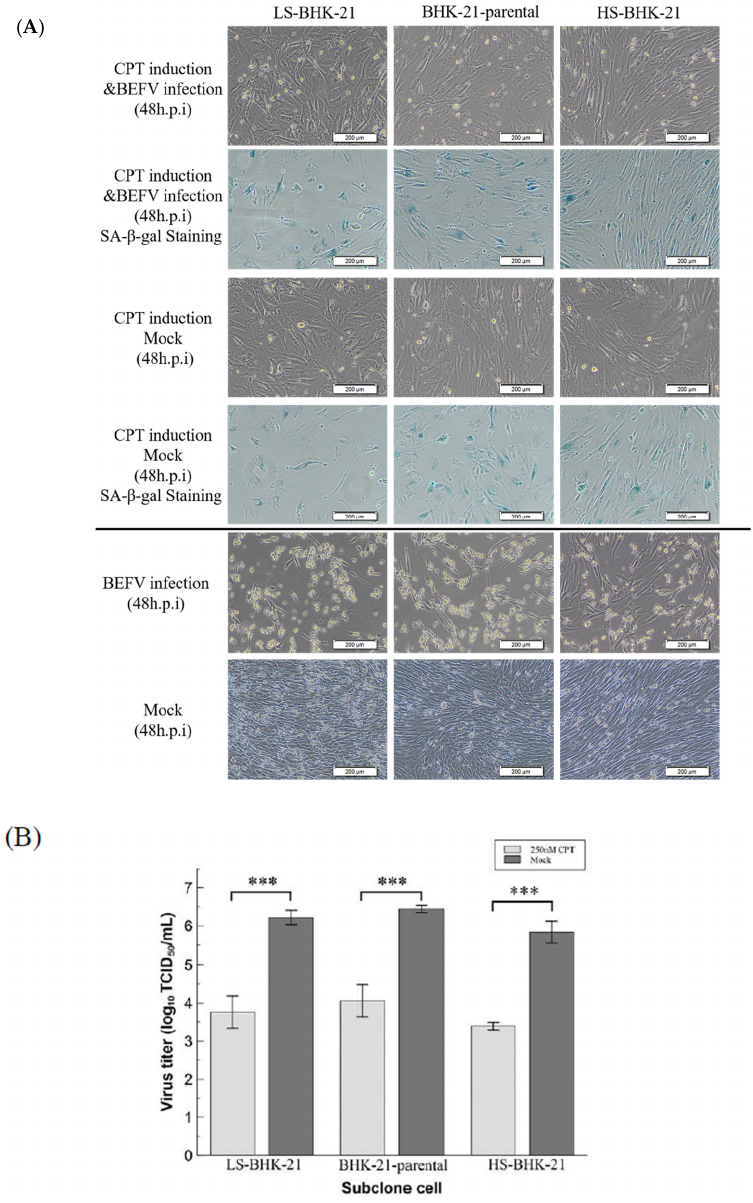
Figure 5. CPT induced senescence-like cell response inhibited virus replication in BHK-21 parental and subclonal cells. ( A ) The parental and subclonal cells were pretreated with or without CPT (250 nM) for 24 hr, and then infected by BEFV. The senescence-like cell response was determined by SA- β -gal staining and imaged by 400 × microscope, and the scale bar shows 200 µm. ( B ) The virus titer in the supernatant from CPT pretreatment assay ( n = 3) were analyzed by TCID 50 and analyzed by t -test. *** p < 0.001.